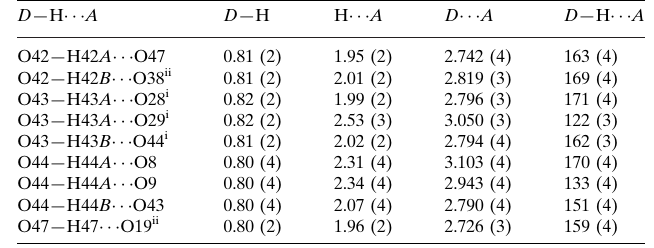
Hydrogen-bond geometry (A˚ , (cid:5)